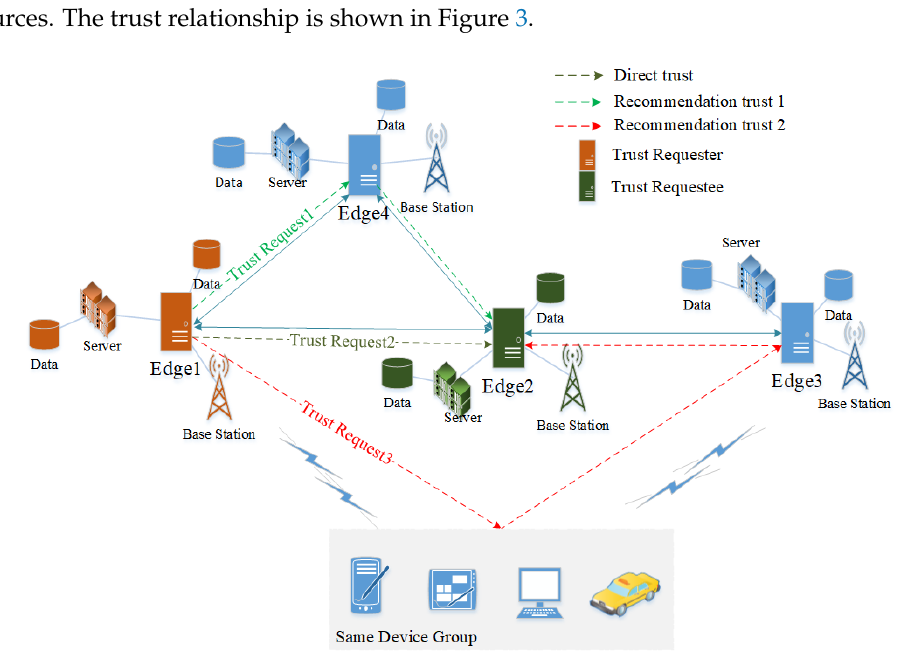
Figure 3. Trust relationship in edge